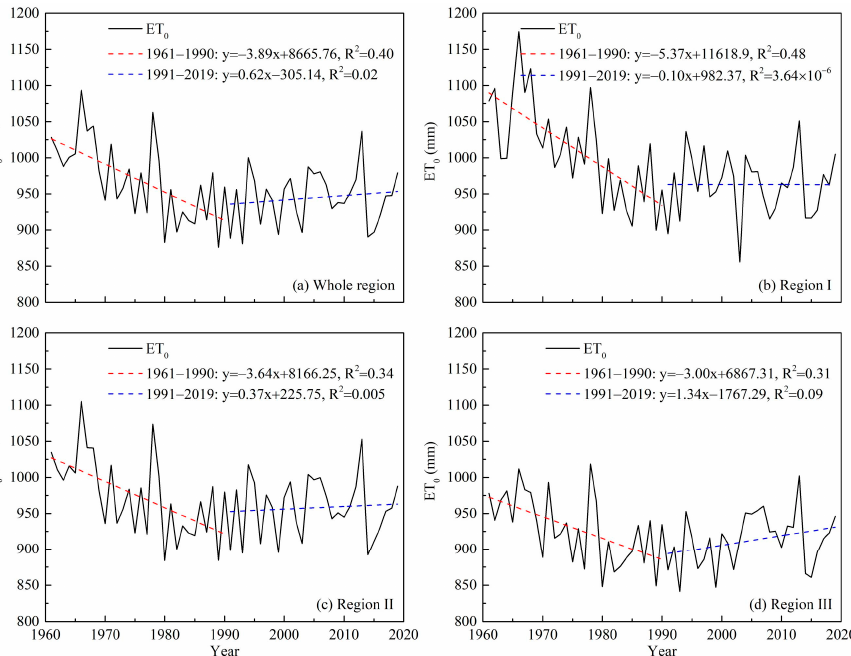
Figure 2. Temporal variations of ET 0 during 1961–2019 in Anhui province ( a ) Whole region, ( b ) Region I, ( c ) Region II, ( d ) Region III.